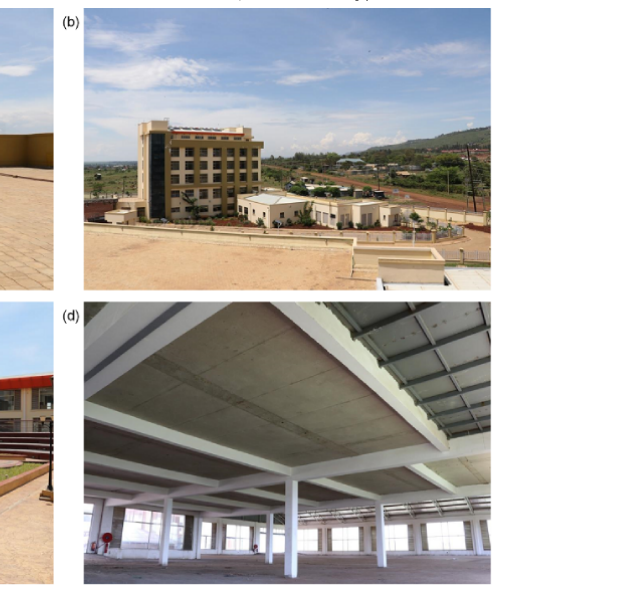
Figure 1. Images showing (a and b) the Lake Basin Mall site, (c) a scene from within the mall, and (d) the hypermarket